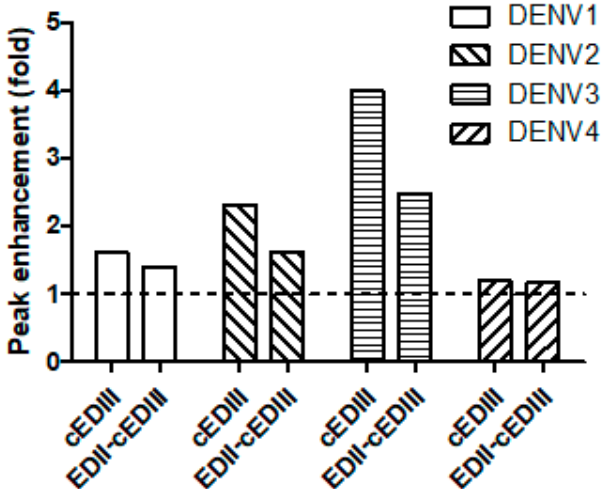
Figure 3. Antibody-dependent enhancement (ADE) of DENV infection by Ab treatment in U937 cells. Fold enhancement was determined by comparing the value obtained by Ab treatment with that obtained without Ab treatment. Peak enhancement was the highest fold enhancement induced by Ab treatment among the various Ab concentrations tested. The dotted line represents the fold change relative to DENV infection without Ab treatment. A representative result from two independent experiments is shown.